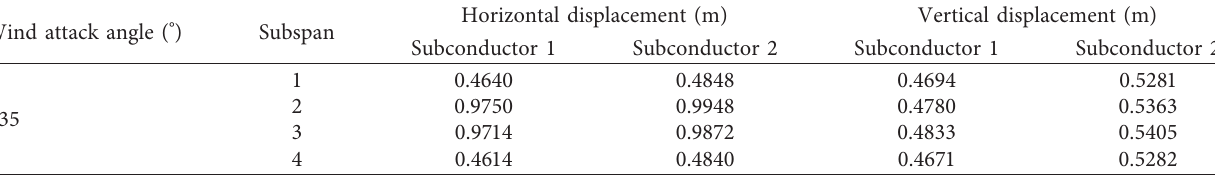
Table 6: Oscillation amplitudes at each subspan midpoint between two subconductors under the wind attack angle of − 35 ° ( I � 500A). Wind attack angle ( ° )